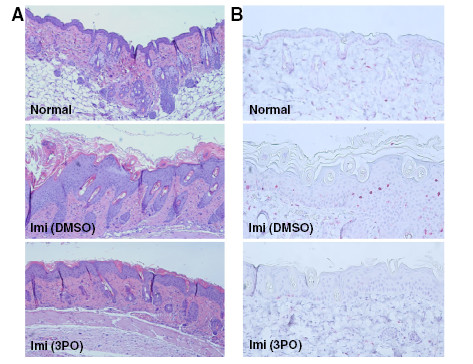
3PO suppresses the increase in epidermal thickness and CD3+T cell infiltration caused by imiquimod. BALB/c mice were administered a daily topical dose of 62.5 mg of imiquimod cream (5%) over a shaved area on the back for 5 days and thirty minutes following each daily administration of imiquimod, the mice were injected intraperitoneally with either DMSO or 3PO 0.07 mg/gm daily. (A) After 5 daily topical applications of imiquimod with intraperitoneal administration of DMSO or 3PO, the exposed skin was resected, fixed in formalin, embedded in paraffin, sectioned and stained with hematoxylin and eosin. (B) After 5 daily topical applications of imiquimod with intraperitoneal administration of DMSO or 3PO, the exposed skin was resected, fixed in formalin, embedded in paraffin, sectioned and CD3+ T cells were detected by immunohistochemistry. Data are representative of three independent experiments.